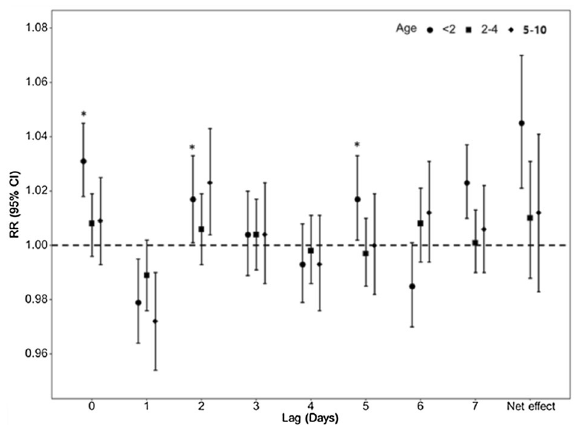
Figure 2. Relative risks of PM 2.5 for acute otitis media according to lag times in three age groups. Lag 0–7 means the days prior to acute otitis media.